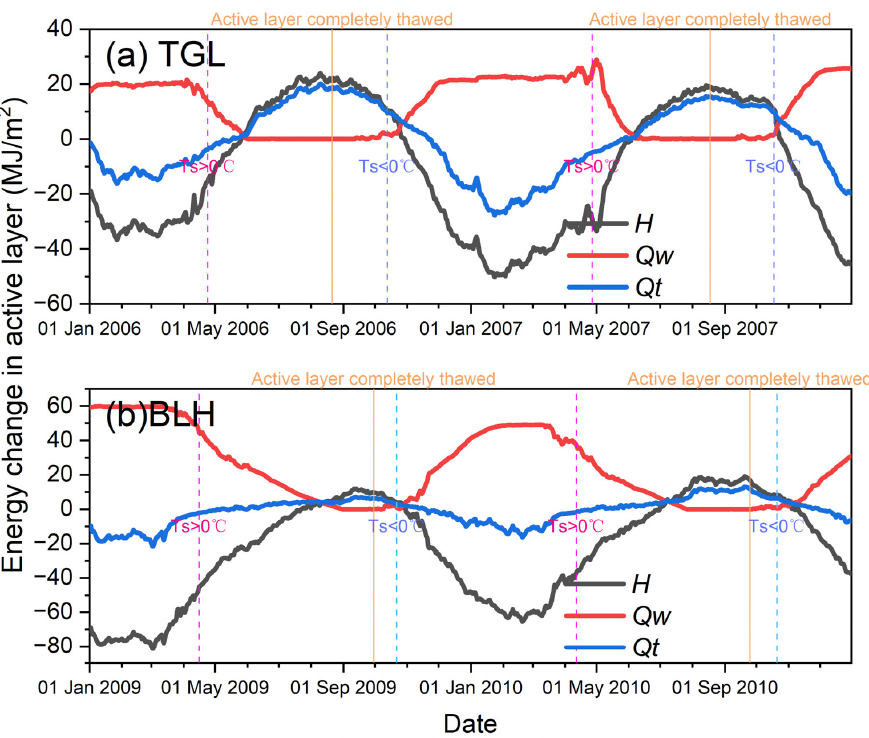
Figure 6. The diurnal energy changes in the active layer at ( a ) TGL and ( b ) BLH.